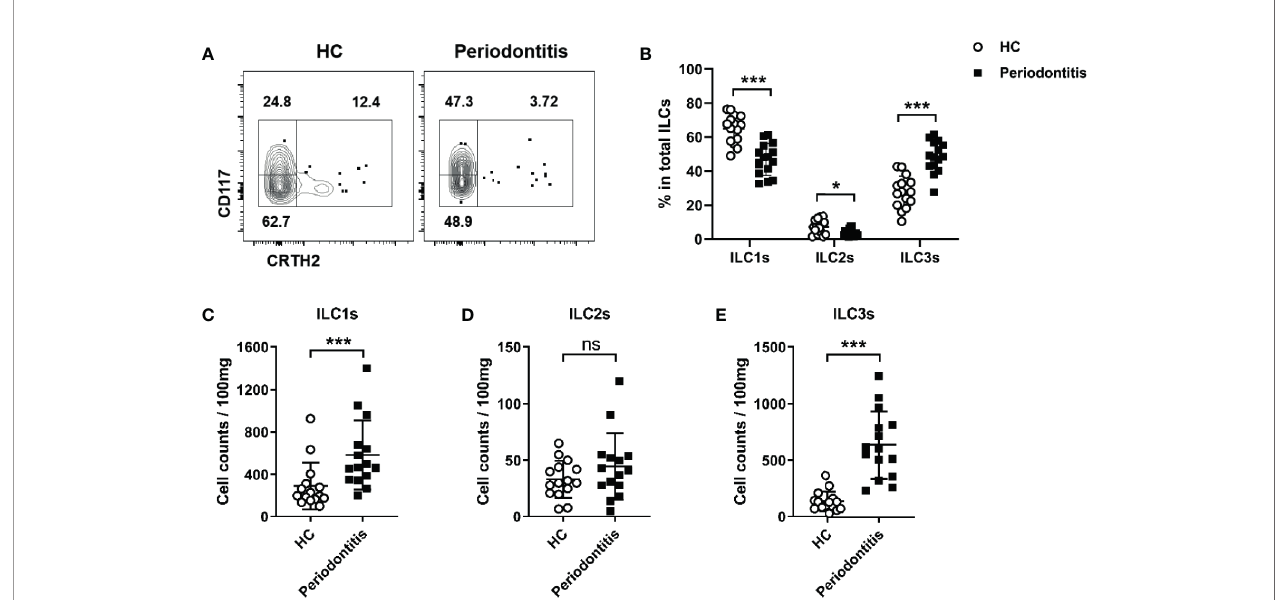
FIGURE 2 | Distribution of distinct ILCs subsets in periodontal ligament of healthy controls and periodontitis patients. (A) Representative fl ow cytometry analysis of ILC1s, ILC2s, and ILC3s in periodontal ligament from healthy individuals (left) and periodontitis patients (right). (B) Frequencies (in total ILCs) of ILC1s, ILC2s, and ILC3s in periodontal ligament from healthy individuals and periodontitis patients. Absolute cell numbers (per 100 mg tissue) of (C) ILC1s, (D) ILC2s, and (E) ILC3s in periodontal ligament from healthy individuals and periodontitis patients. n=15 for each group. *p < 0.05, ***p < 0.001, ns, not signi fi cant.